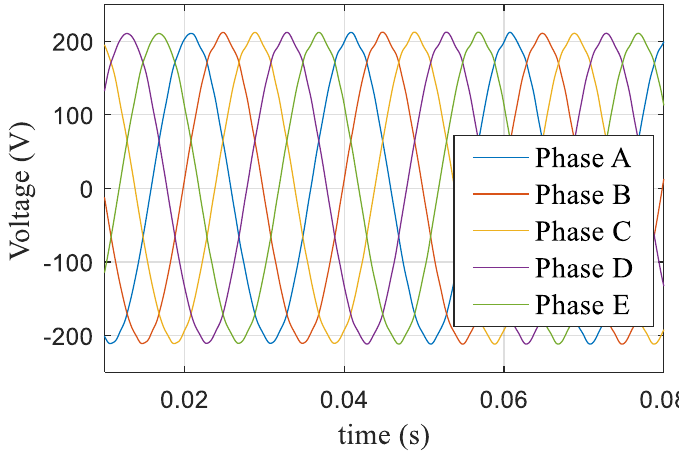
Figure 13. Action time of the space vector voltage at m = 1.0514.